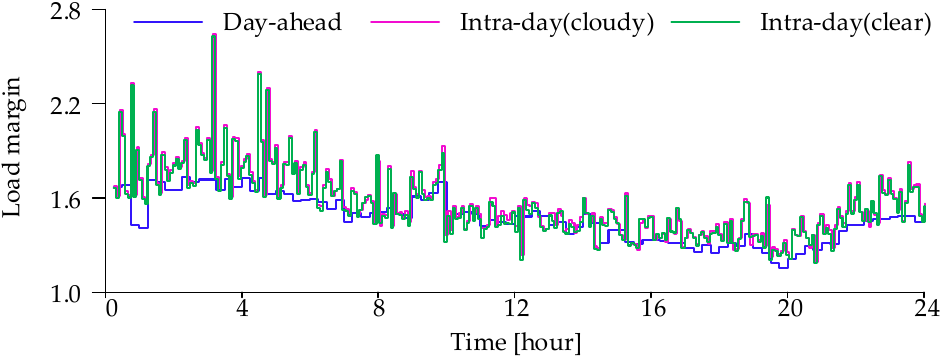
Figure 13. Load margins for the day-ahead and intra-day scenarios.